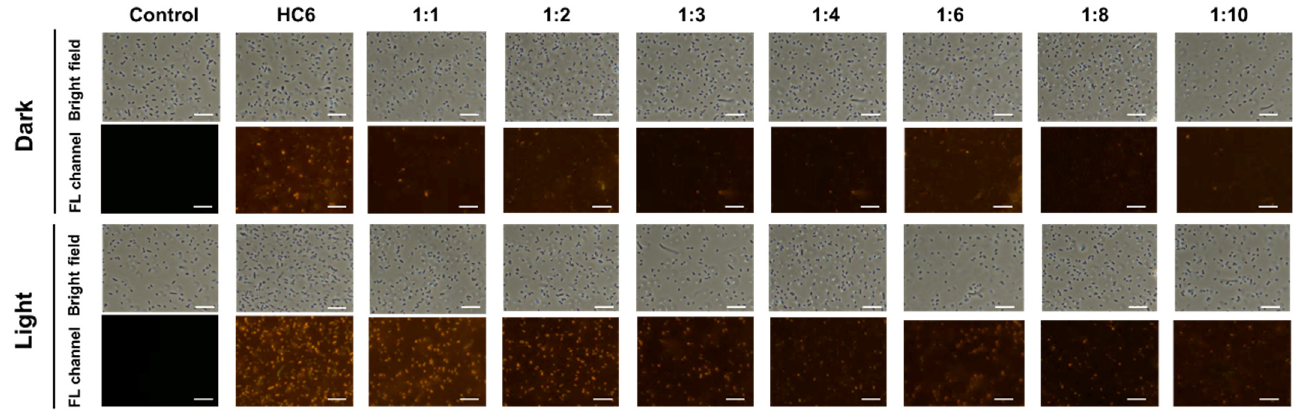
Figure 5. Fluorescence microscope images of E. coli before and after binding with HC6 or HC6/CB[7] in different proportions in dark and under light (65 mW/cm 2 ) irradiation. The red spots are fluores- cent bacteria attached with HC6 or HC6/CB[7]. [HC6] = 25 µ M, [CB[7]] = 0, 25, 50, 75, 100, 150, 200, 250 µ M, the scale is 20 µ m.